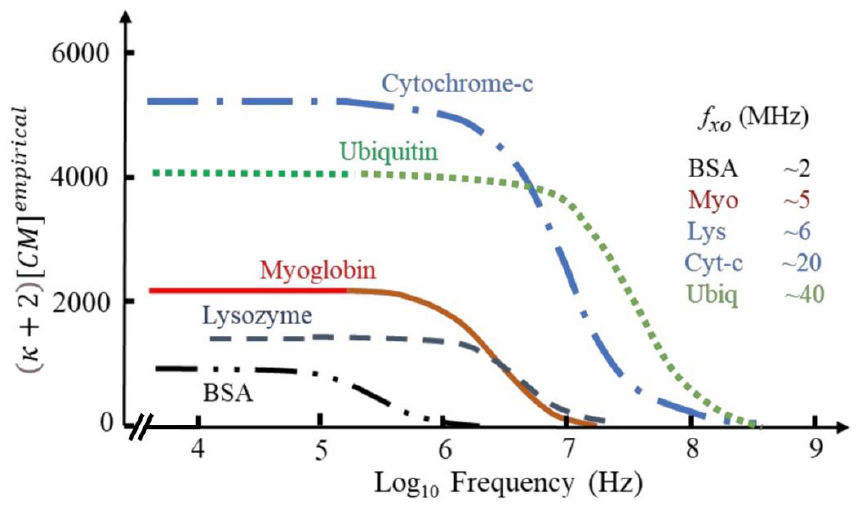
Figure 2. The frequency-dependence of the empirical factor ( κ + 2) [CM] for a variety of proteins. Adapted under terms of the CC-BY license ref. [64] 2022, R. Pethig, published by MDPI.